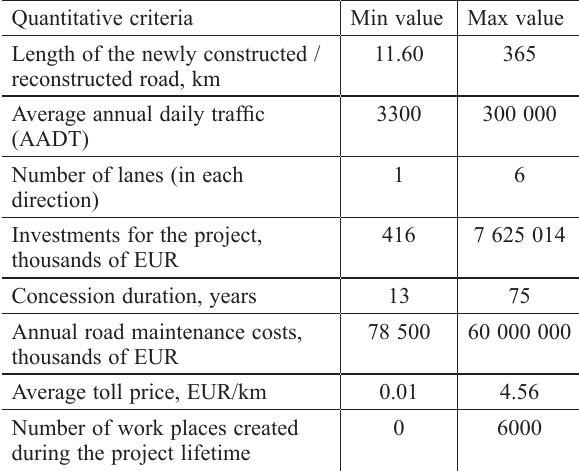
Table 1. PPP road infrastructure construction projects quantitative criteria Quantitative